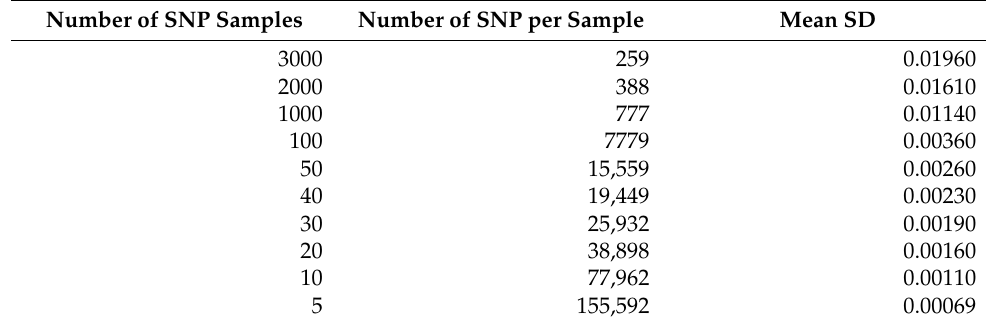
Table 1. Standard deviation among technical errors for animals contributions estimated by bootstrap- ping sub-samples of SNP; sampled without replacement 1